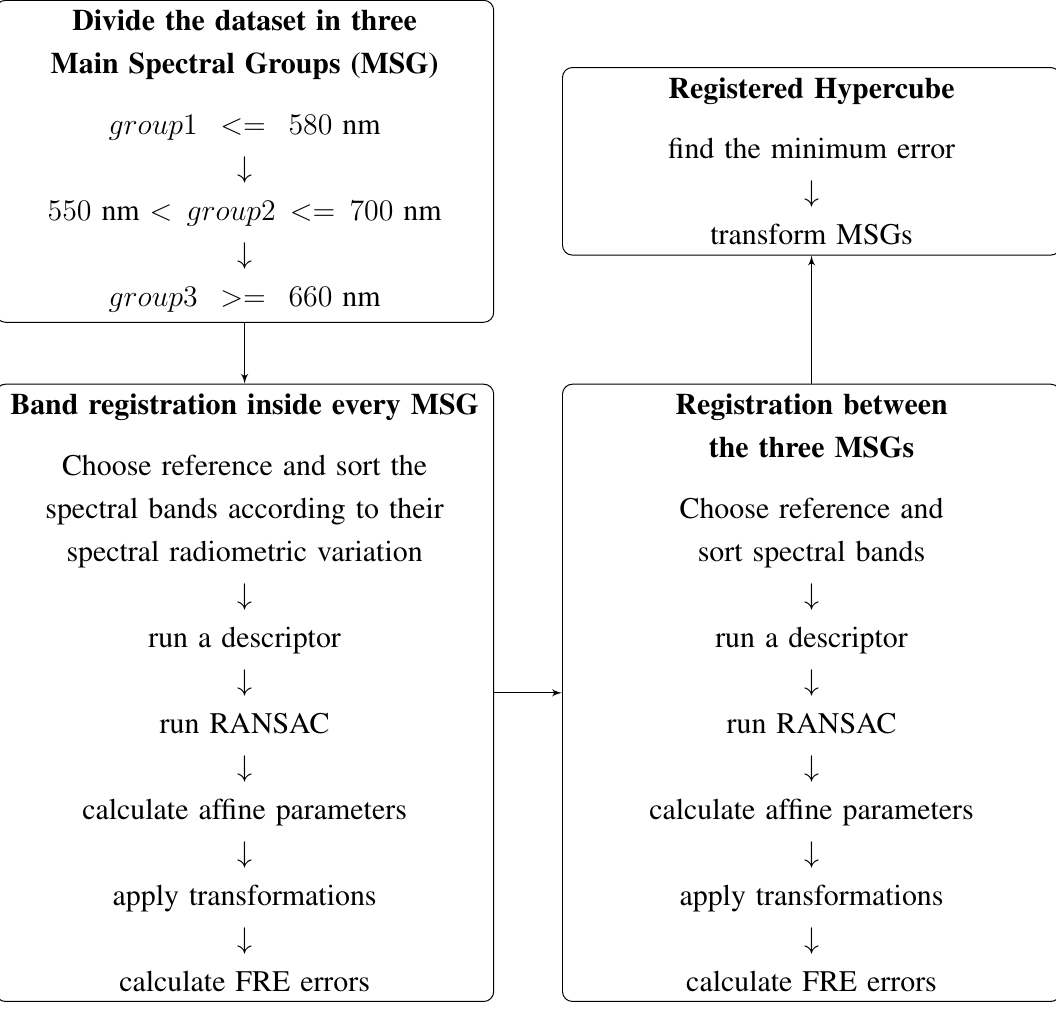
Figure 2. The flowchart of the developed